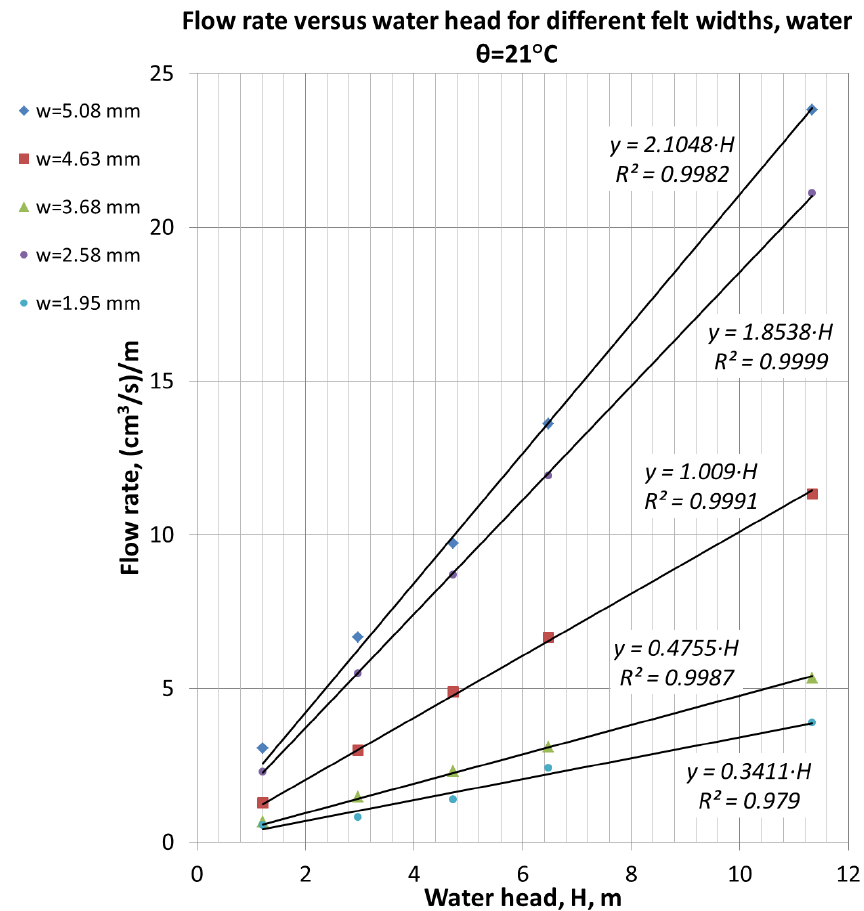
Figure 4. Dependence of a flow rate through cell filled with CF versus water pressure for five different felt thicknesses was obtained by felt compression.